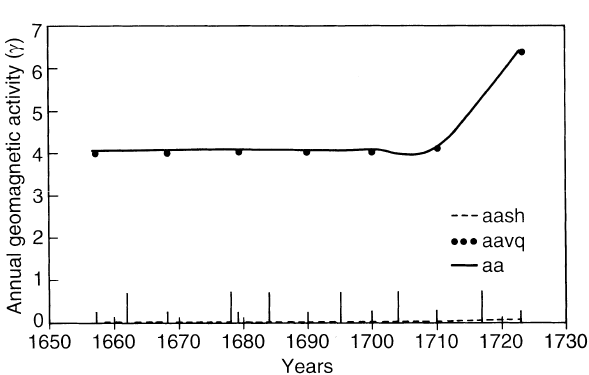
Fig. 2. Solar-minimum annual average index of very quiet geomag- netic times during 1645–1715: aa vq (cid:136) 4 : 06 (cid:135) 0 : 019 R max (cid:133) r (cid:136) 0 : 83 (cid:134) , dots. Solar-minimum annual average index of shock-related geomag- netic activity during 1645–1715 aa sh (cid:136) 0 : 048 Rz , dashed line . Solar- minimum annual average index of geomagnetic activity during 1645– 1715, given by aa (cid:136) aa vq (cid:135) aa sh , solid line . The thin short vertical lines on the x axis correspond to the years of the solar maximum. The thick ones correspond to the years of the solar